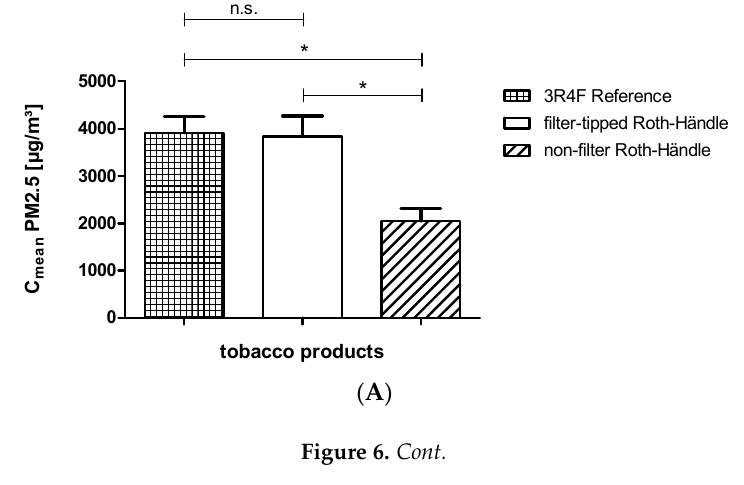
Figure 5. The interval from ignition to extinction (5 min) was evaluated by measuring the area under the curve (AUC) and particulate matter (PM).